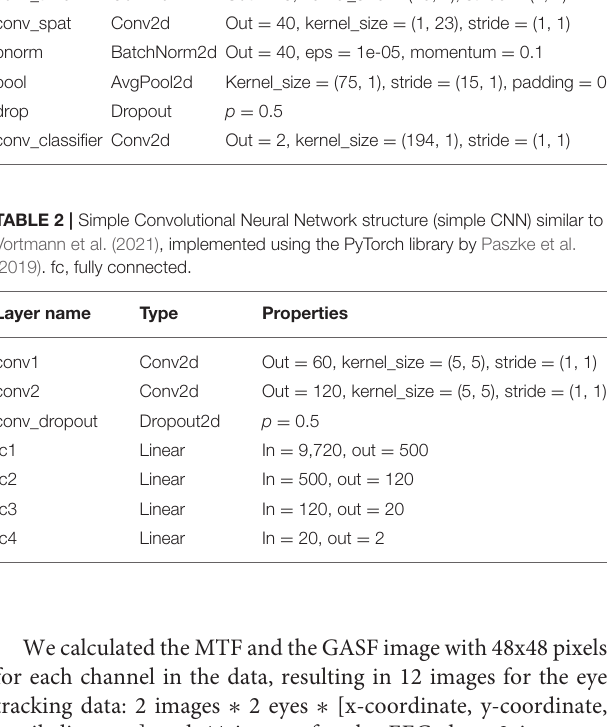
testing data, using 33% for testing (stratified). We trained for